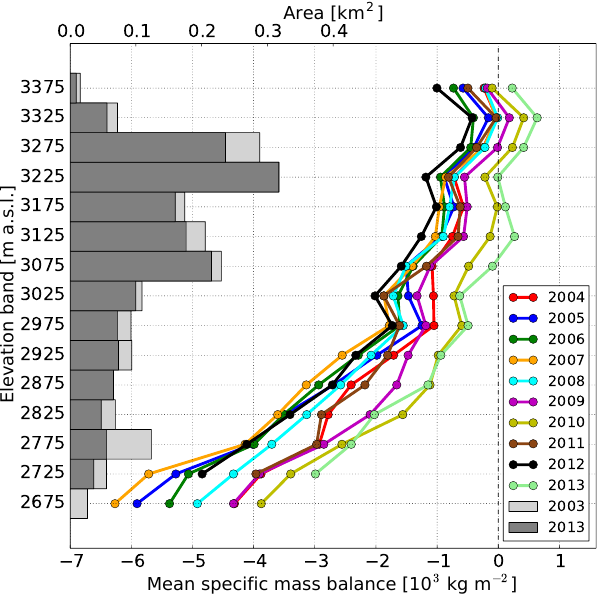
Figure 6. Altitudinal distribution of reanalyzed annual mass bal- ances as well as of the glacier surface area at the beginning (2003) and the end of the study period